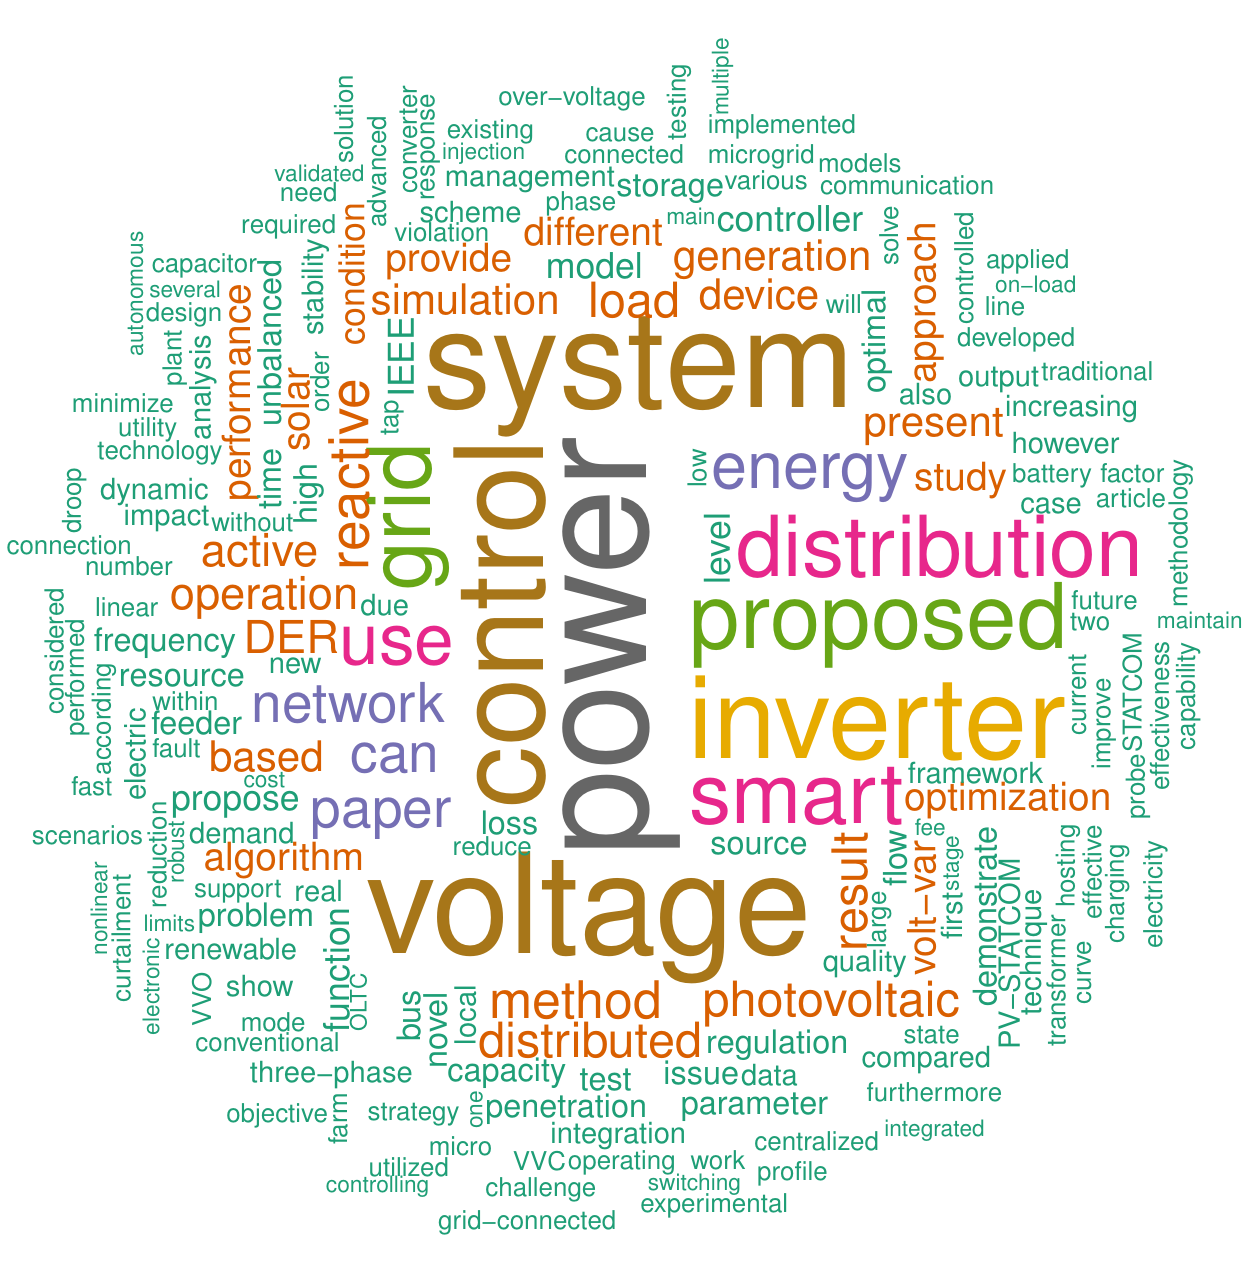
Figure 1. Word cloud generated from abstracts in recent works on smart inverters. The color and font size indicate the relative frequency of the word appearing in the set of